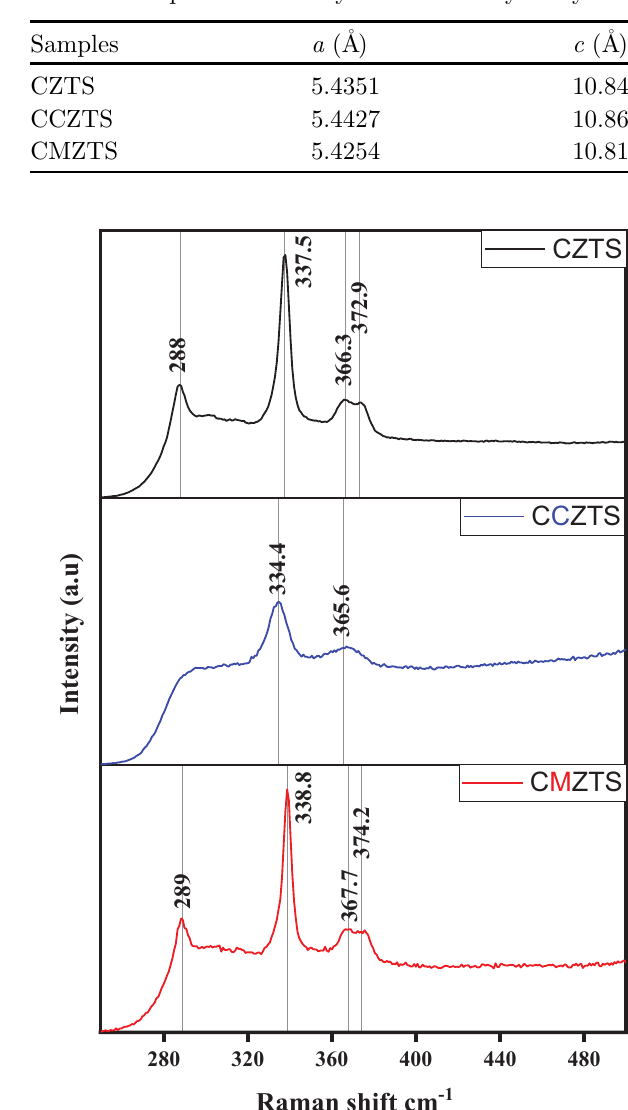
Table 1. Lattice parameters of CZTS, CCZTS and CMZTS samples obtained by Rietveld X-ray analysis.